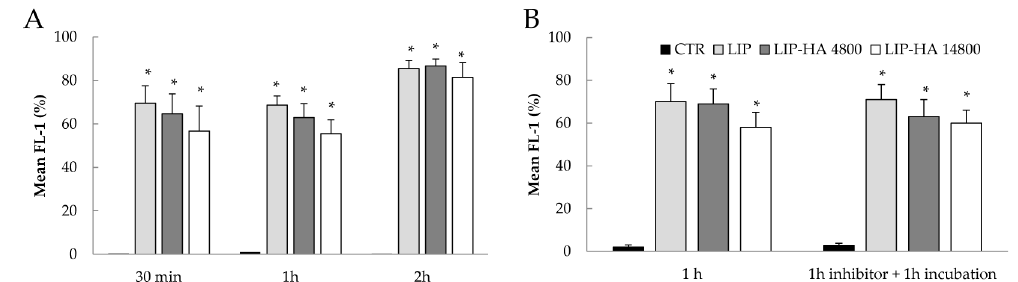
Figure 4. Cellular uptake of fluorescent LIP, LIP-HA4800, and LIP-HA14800 in THP-1 cells. Analysis of internalization of different liposomal formulations ( A ) and in presence of high MW HA conducted in THP-1 cells by flow cytometry after incubation for the indicated time ( B ). Histograms represent mean ± standard deviation expressed as percentage of fluorescence intensity of liposomes fluorescence signals of three independent experiments. *, p < 0.001 vs. CTR.